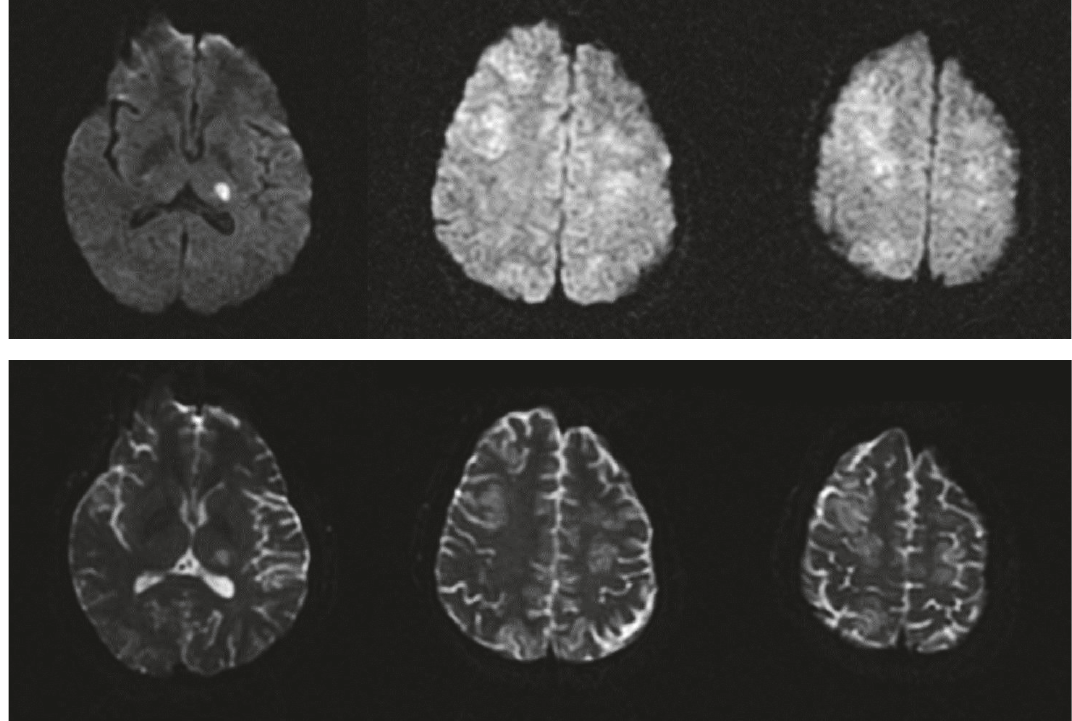
Figure 2: Case No. 1. DWI sequences (upper images) and ADC maps (lower images) showing diffusion restriction in left thalamus and mild signal hyperintensity in the same areas described in Figure